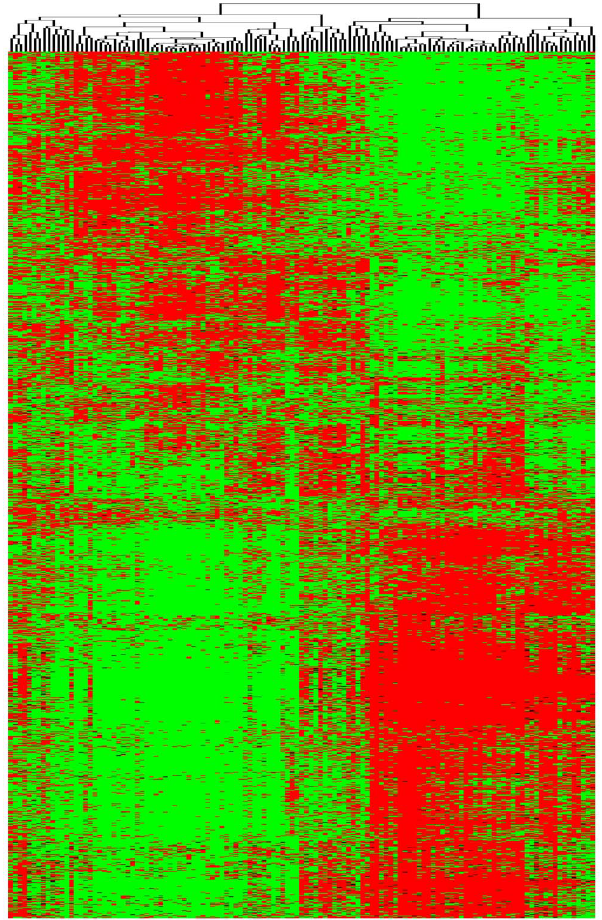
Figure 5. ICC subclasses. Based on expression profiles of genes in CNV-ICC-TRN, the non-negative matrix factorization–based algorithm divided ICC samples to two classes cluster I (right branch) and cluster P (left branch). This figure is heat map of differentially expressed genes between two classes.